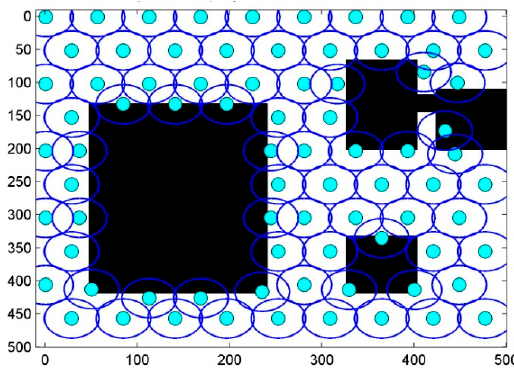
Figure 22. Optimal sensor deployment on area “UL-B”.